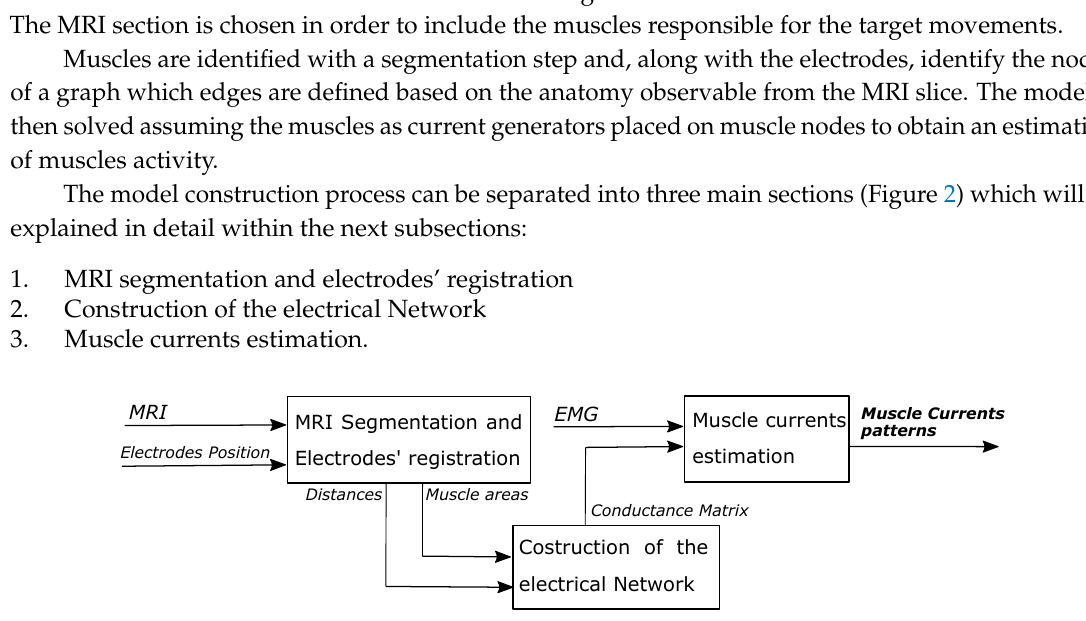
Figure 2. Diagram of the proposed approach. Three main parts can be identified, MRI segmentation and electrodes’ registration, Construction of the electrode network and muscle currents estimation. From the left, the MRI segmentation and electrodes’ registration block process the information in the MRI and about the electrodes’ position to estimate the distance between the elements (muscles and electrodes) in the MRI and the muscles’ cross section areas. This information is then used to create and weight the edges of a graph describing the interaction between the nodes representing muscles and electrodes. In the Muscle current estimation block, the EMG is exploited to obtain an estimation of the muscle activation patterns solving an inverse problem using the conductance matrix that describes the graph and the related electrical